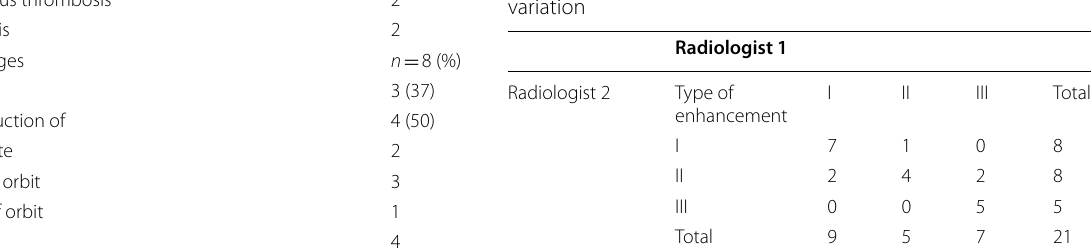
Table 5 Contrast enhancement in sinuses on MRI